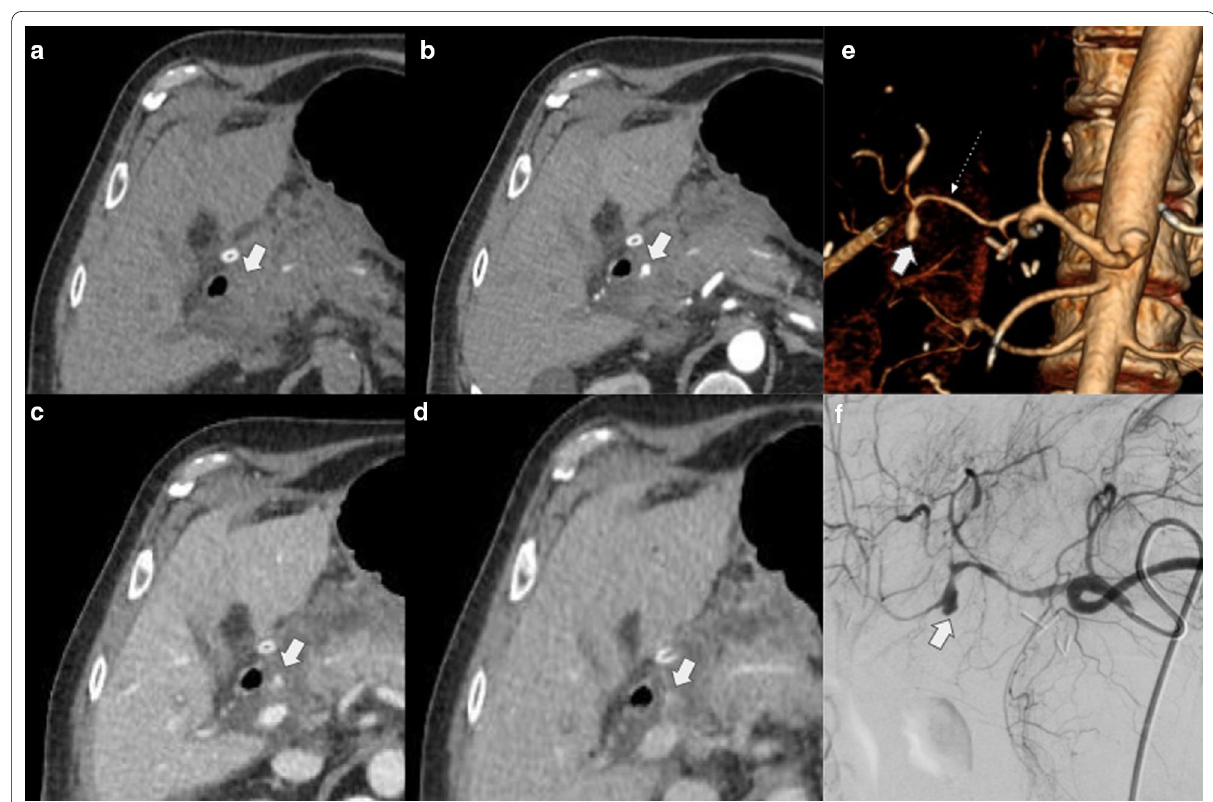
Fig. 27 Right hepatic pseudoaneurysm. 78-year-old male patient with a history of pancreaticoduodenectomy with right hepatic artery reconstruction for pancreatic adenocarcinoma under study due to hematocrit decrease. ( a , b , c , d ) Multiphase CT shows a focus of focal enhancement in arterial phase in the surgical bed (arrow in b ), which persists in post-arterial phases (big arrows in c and d ). ( e ) 3D reconstruction shows saccular dilatation (arrow) dependence of the right branch of the hepatic artery (dotted arrow). ( f ) Digital angiography confirms the diagnosis of